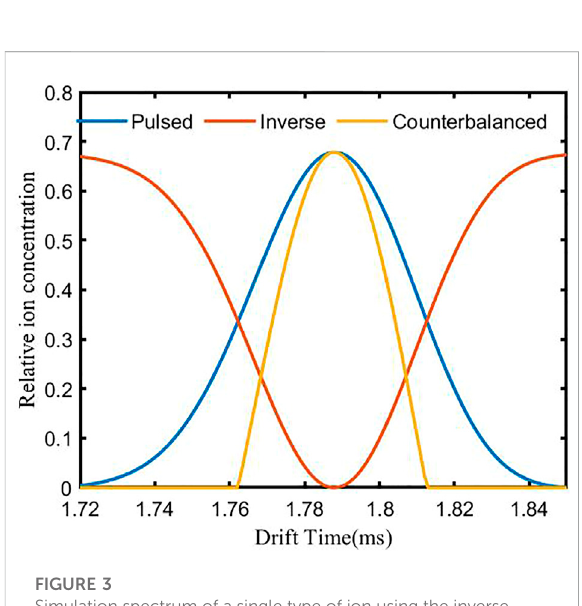
FIGURE 3 Simulation spectrum of a single type of ion using the inverse diffusion counterbalance method.